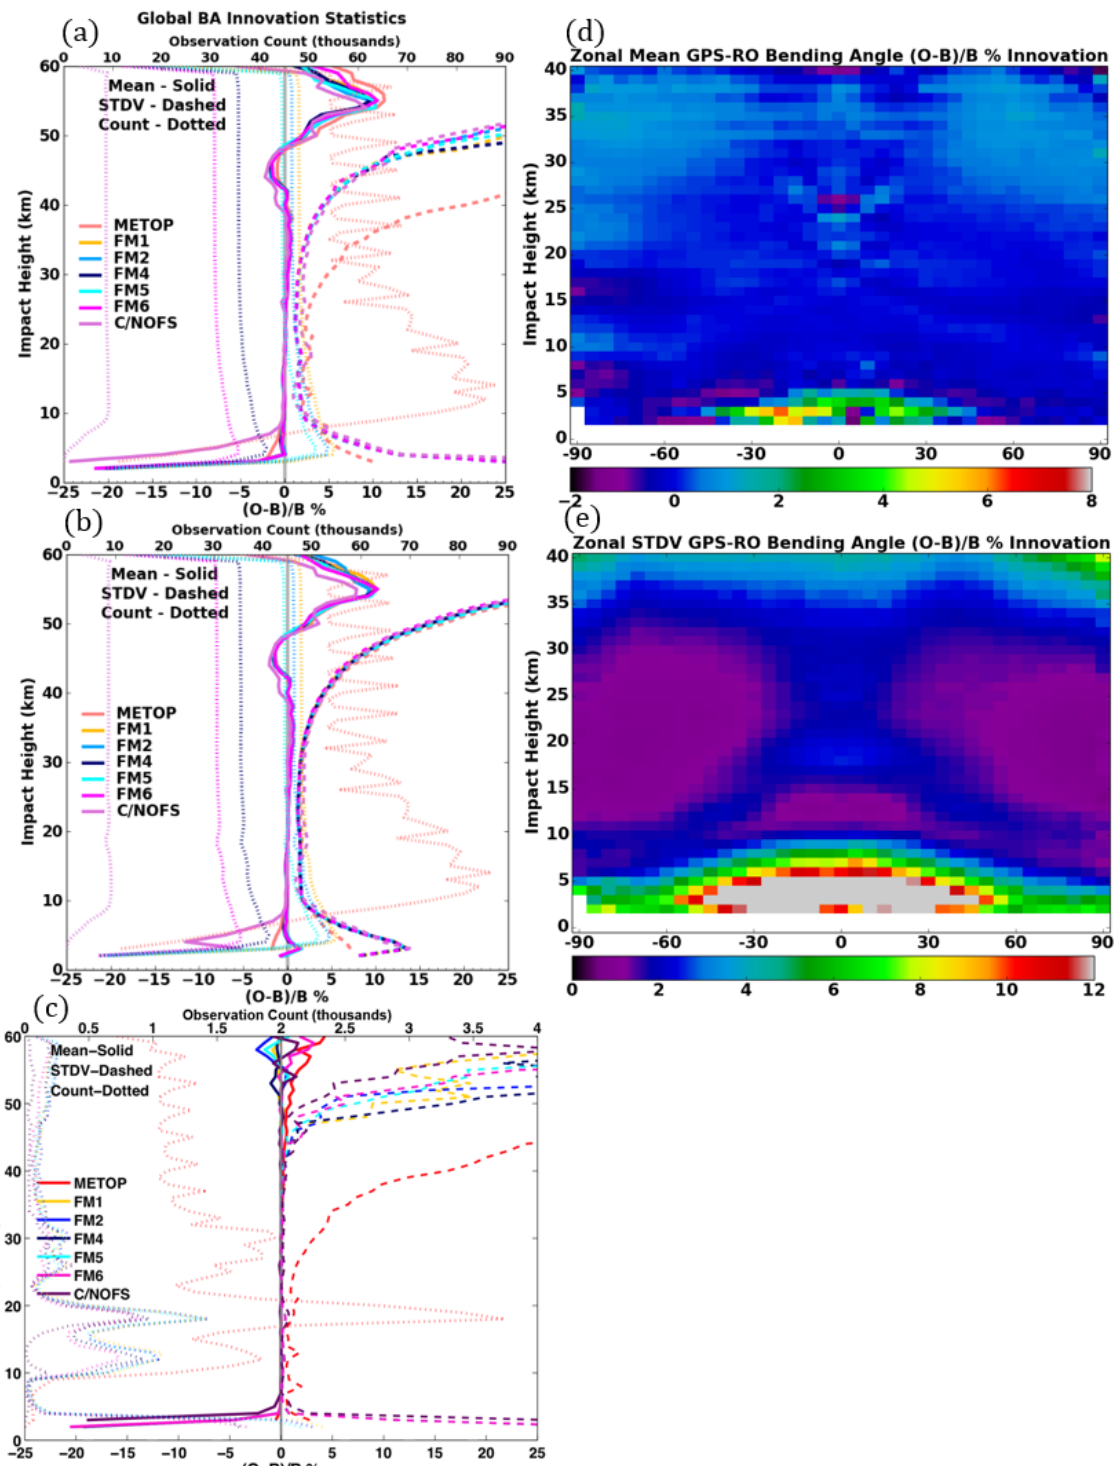
Figure 3. Departure statistics between the observation and background calculations of bending angles for the month of November 2012. ( a and b ) Global mean bending-angle innovation and number of observations as a function of impact parameter before and after quality control, respectively. (c) Difference of departure statistics between ( a and b ) ( a minus b ). Statistics are calculated based on satellite data and displayed with different colors. ( d and e ) Zonal mean and standard deviation of bending-angle innovation for all satellites after quality